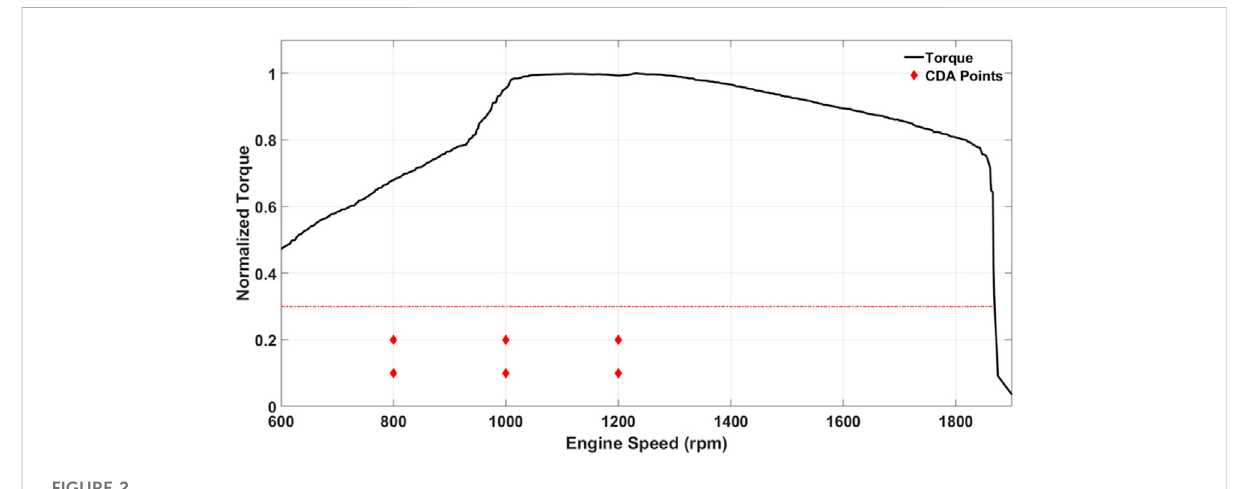
FIGURE 2 Torque curve with CDA test